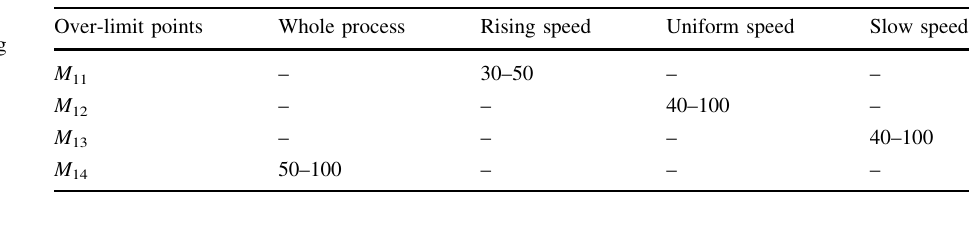
Table 11 Rules for local resistance reducing of closing